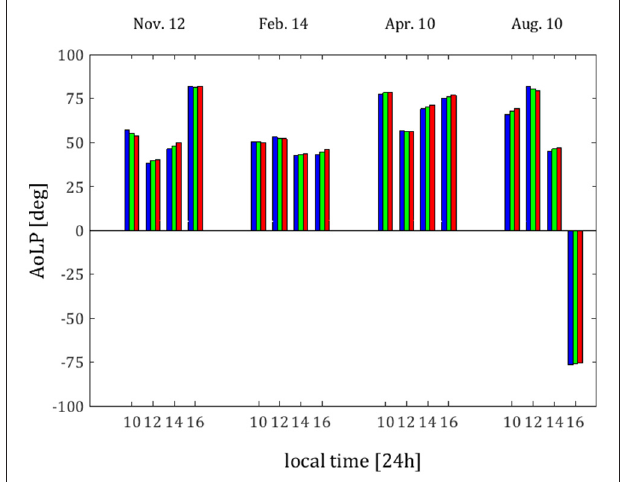
FIGURE 6 | AoLP as obtained from spectrophotometer method on November 12th, 2015, February 14th, 2016, April 10th, 2016, and August 10th 2016. The dates and time of day of each measurement are indicated along the horizontal axis. From each measurement, weighted values from blue, green, and red wavebands are presented (each in its own